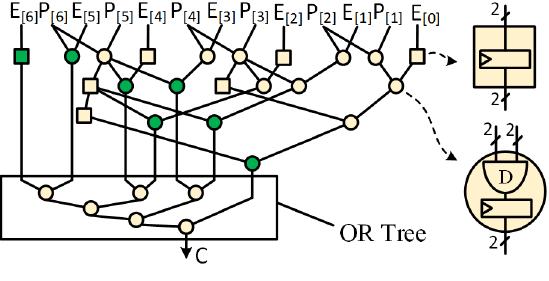
Figure 12: Hardware design of the masked comparator. The circles and squares on the right represent DOM-indep AND gate and a register. The green circles denote completed partial products of Equation 13 which are fed to the OR Tree for final evaluation of C .